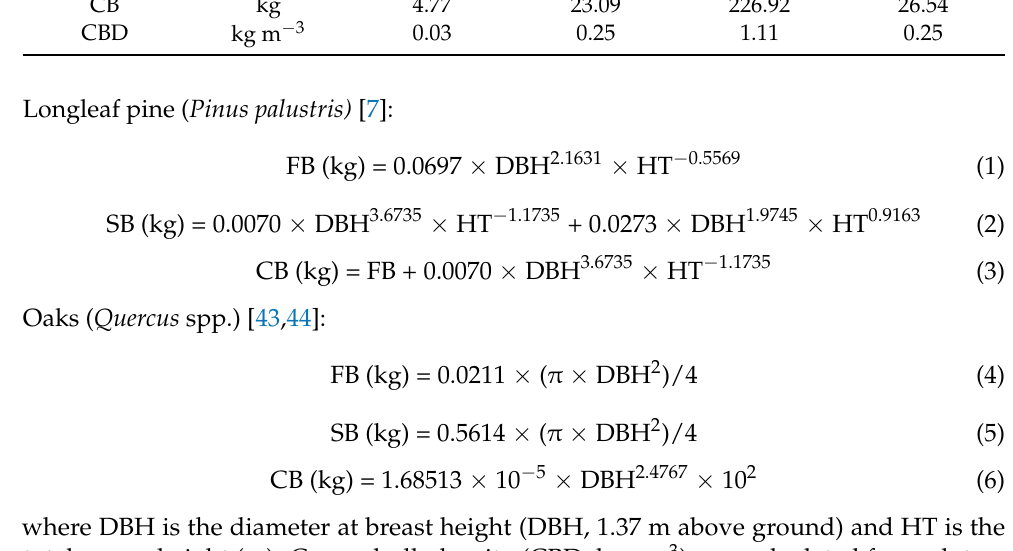
Table 1. Descriptive statistics of field measurements of 205 trees included in the study: height (Ht); diameter at breast height (DBH); canopy base height (CBH); crown width (CW; major and minor); foliage biomass (FB); stem and branches biomass (SB); crown biomass (CB); and crown bulk density (CBD). Attributes Units Min. Mean Max. sd HT m 3.90 10.65 16.90 2.96 DBH cm 10.0 16.40 39.50 CBH m CW m 1.30 FB kg SB kg 22.14 CB kg CBD kg m − 3